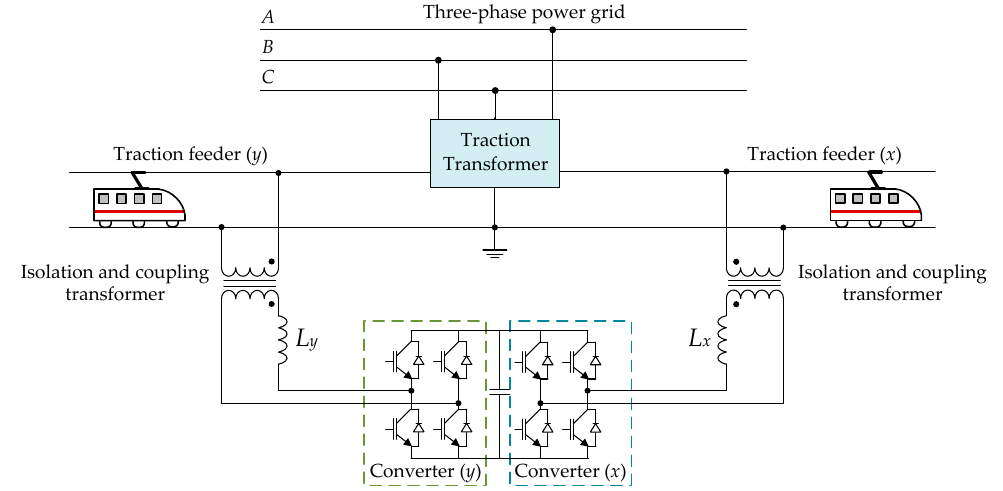
Table 5. Components quantities of the FB-RPC.